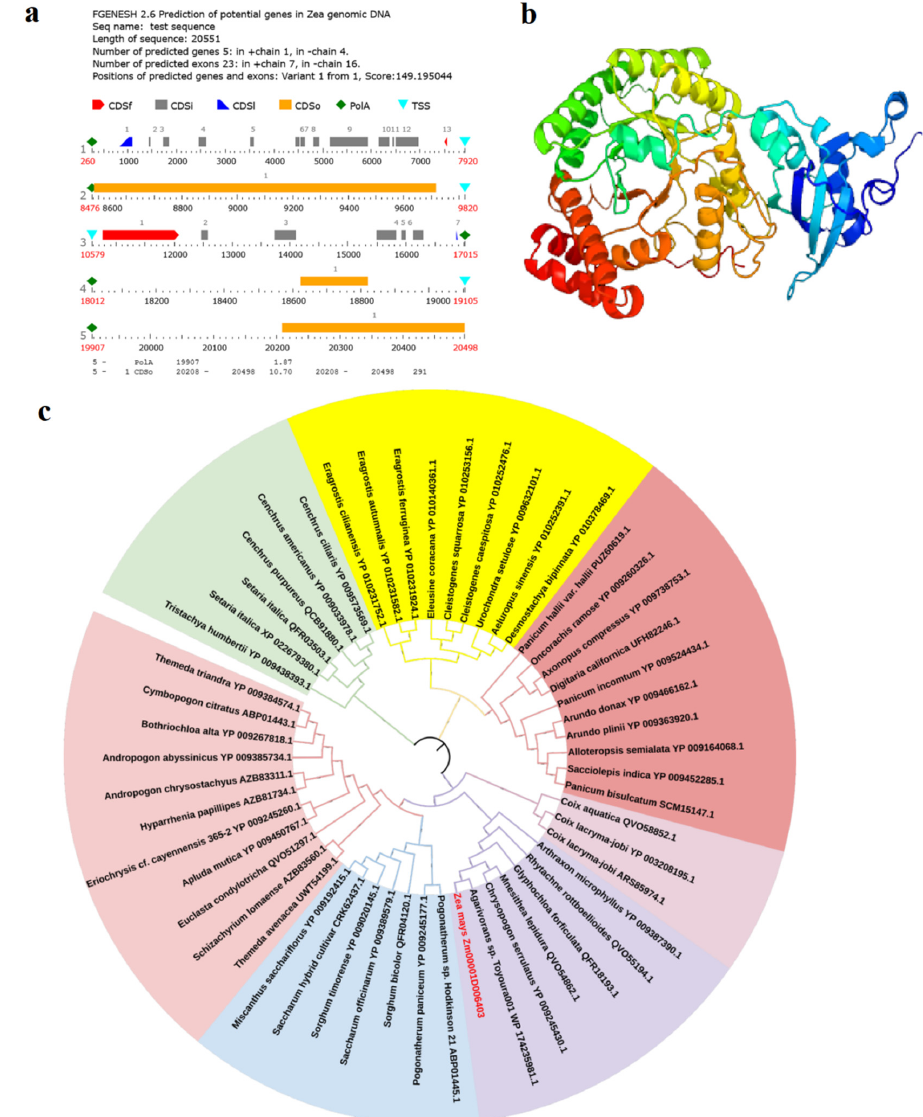
Figure 8. Bioinformatics analysis of the candidate gene Zm00001d006403 . ( a ) Gene prediction of Zm00001d006403 gene (TSS: Transcription start site; CDSf: Start exon; CDSI: Terminal exon). ( b ) Tertiary structure of Zm00001d006403 protein. ( c ) Phylogenetic analysis of Zm00001d006403 protein.